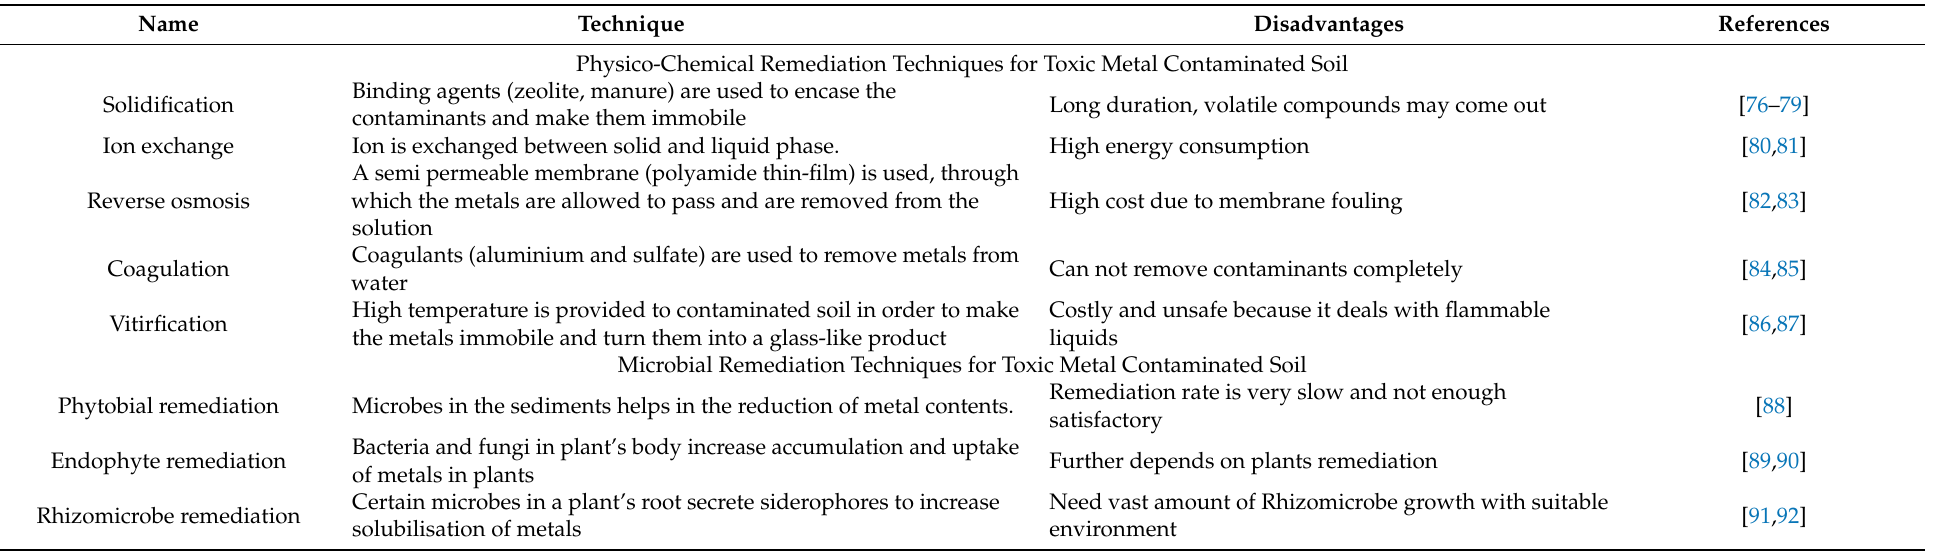
Table 2. Physico-chemical and microbial remediation techniques for toxic metal contaminated